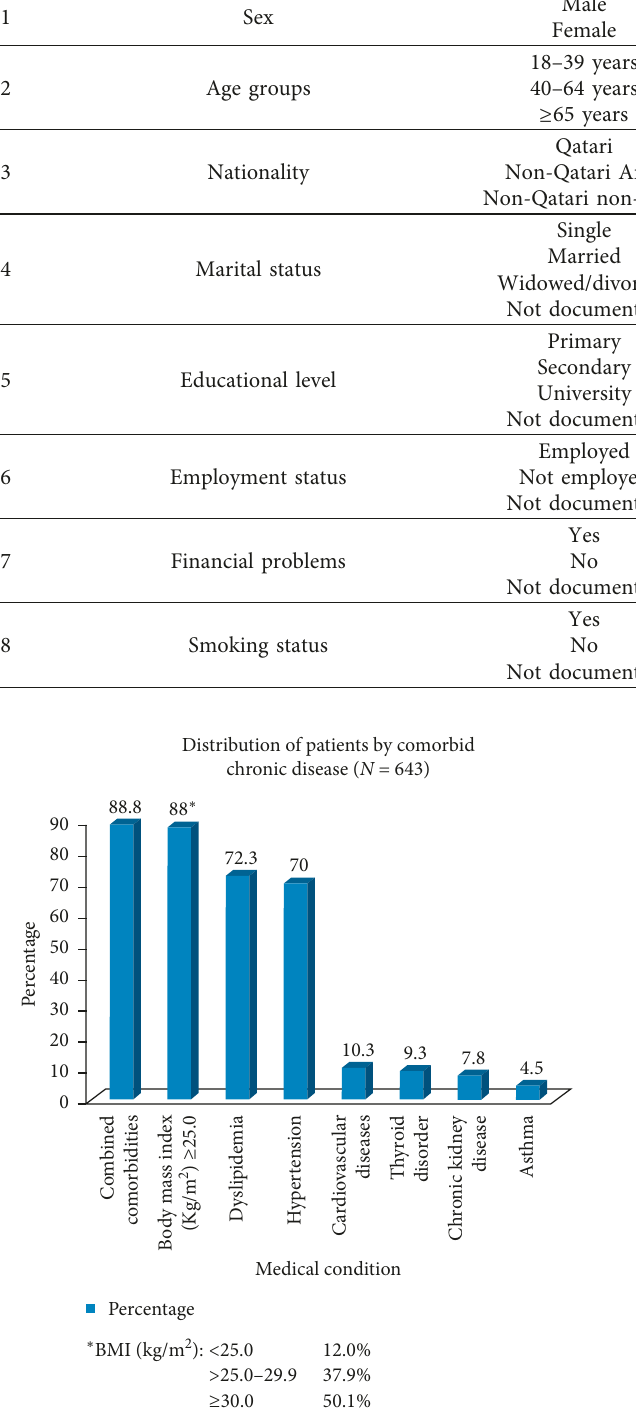
Figure 1: Distribution of patients by comorbid chronic disease ( N �